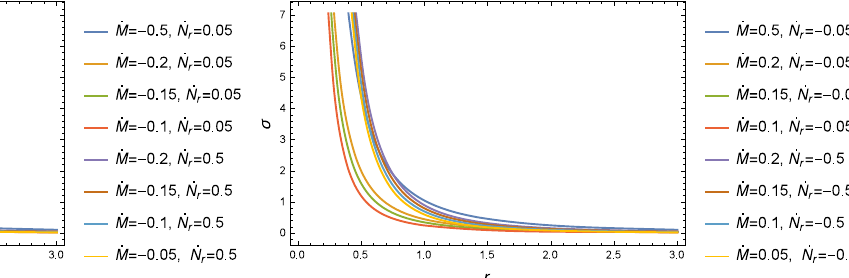
distance r for some typical constant ˙ M and ˙ N r values for (cid:5) = + 1 in the radiation background. Here, σ( r ) is a decreasing function but is positive, and consequently the positive energy condition is satisfied everywhere in spacetime